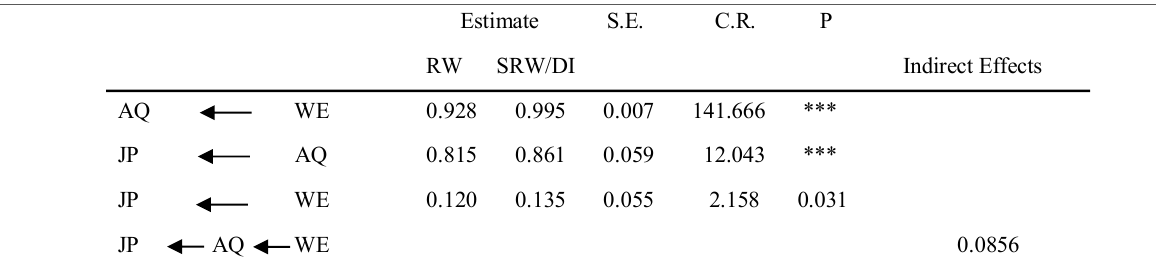
Table 2: Regression Weights, Direct & Indirect Effects